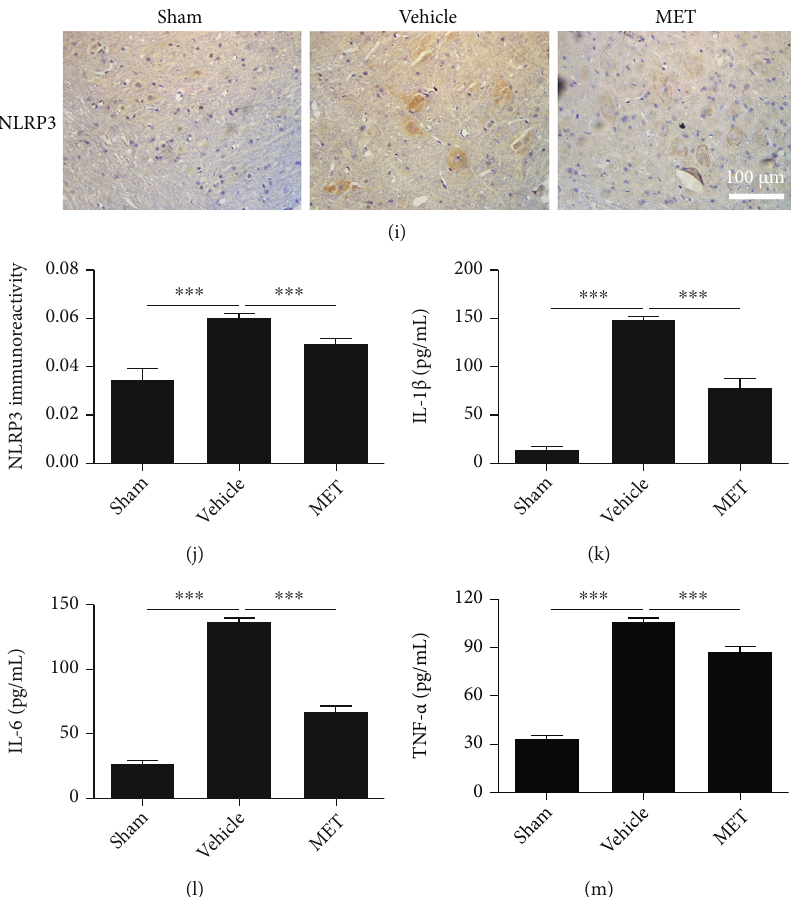
Figure 5: Metformin activates the AMPK/NLRP3 signaling pathway and inhibits in fl ammation after SCI. (a – c) Representative Western blots and quanti fi cation data of the levels of p-AMPK and p-ACC after SCI from each group. All data represent the mean ± SD , ∗∗∗ P < 0 : 001 , n = 3 . (d – h) Representative Western blots and quanti fi cation data of the expression of NLRP3, ASC, Caspase 1, and IL-1 β after SCI from each group. All data represent the mean ± SD , ∗∗∗ P < 0 : 001 , n = 3 . (i, j) Immunohistochemical detection of the levels of NLRP3 protein in each group of rats at 7 days after SCI. Scale bars represent 100 μ m. ∗∗∗ P < 0 : 001 , n = 3 . (k – m) ELISA was used to detect the expression of IL-1 β , IL-6, and TNF- α in the spinal cord tissue homogenate from each group. All data represent the mean ± SD , ∗∗∗ P < 0 : 001 , n = 3